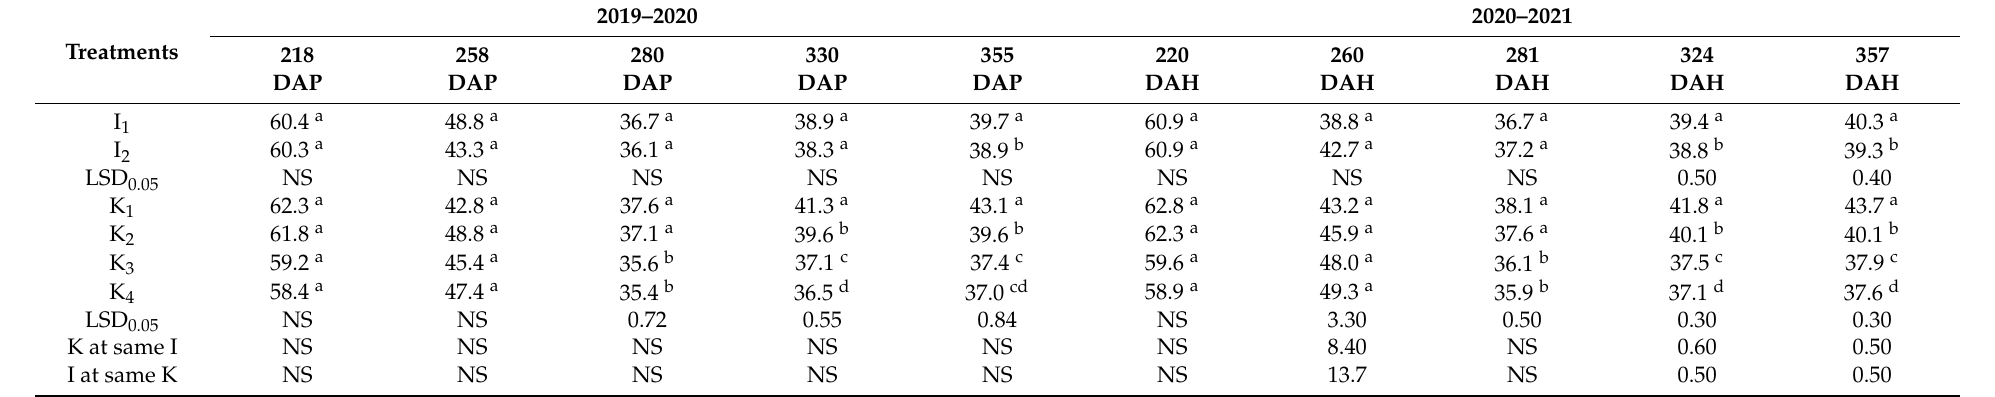
Table 8. Chlorophyll cane content as a function of irrigation and potash levels.